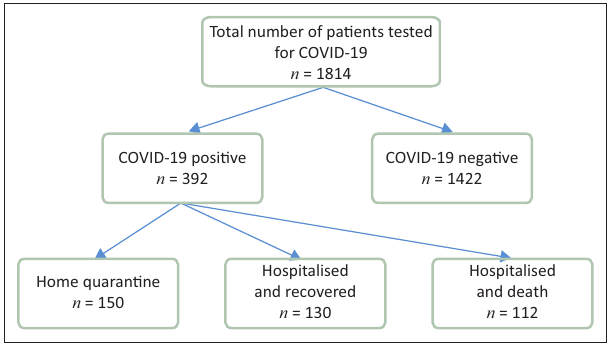
FIGURE 1: Flow chart of patients tested for COVID-19 at Mthatha Regional Hospital.